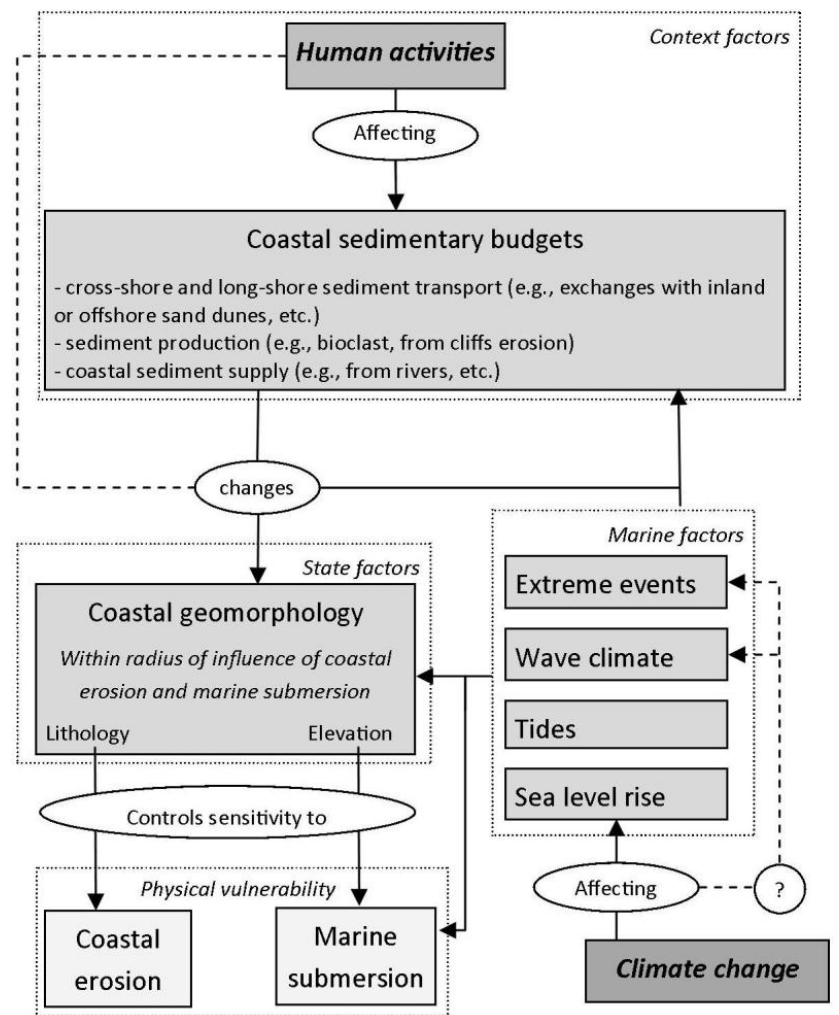
Fig. 2. Simplified diagram of the interactions between various factors controlling the physical vulnerability of coastal areas. highlight if a formation has been observed or interpreted by a geologist. In the two regions, the late Quaternary (Holocene) deposits are sufficiently well detailed to use this information in coastal